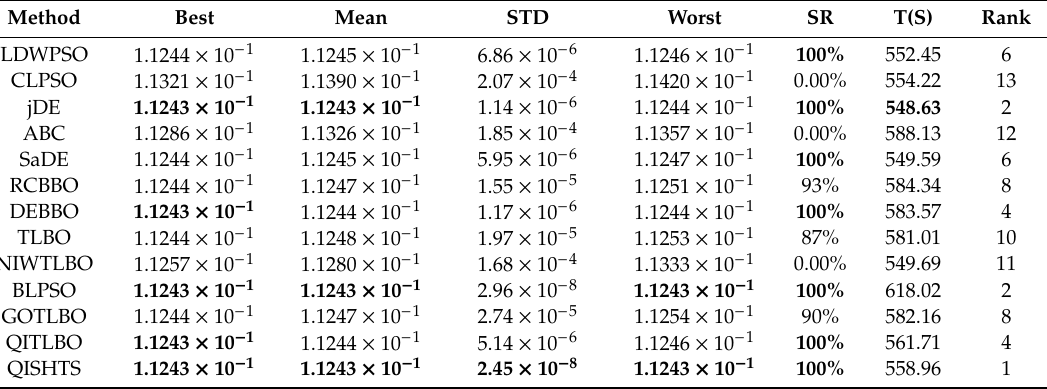
Table 10. Results of the compared algorithms for the six-plate gas absorption tower